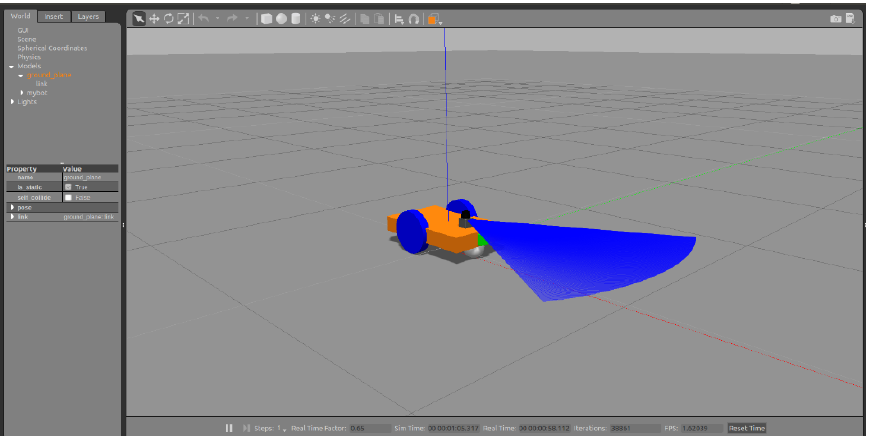
Fig. 9. Robot’s model in